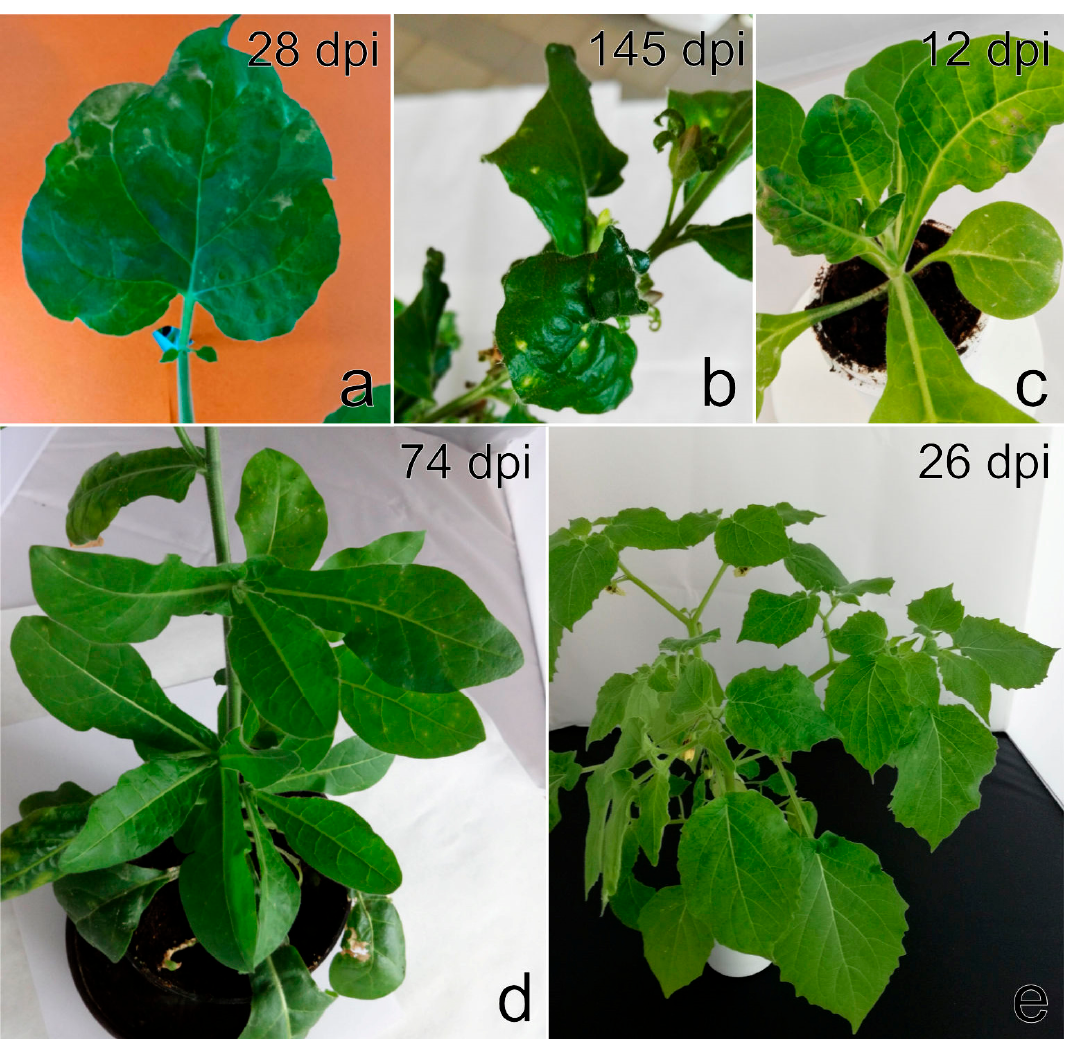
Figure 9. Symptoms on host plants mechanically inoculated with the 1/2017 isolate of StrV-1 (genotype B). ( a ) N. benthamiana leaf with mosaic and severe white sectors and ( b ) symptom development to systemic leaf twisting with irregular white lesions; ( c ) N. occidentalis 37B showing severe blistered mosaic, yellowing and necrosis at the initial phase of infection and ( d ) identical plants in the later stage of infection, which had systemic necrotic spots; ( e ) Physalis floridana showing systemic mild mosaic.